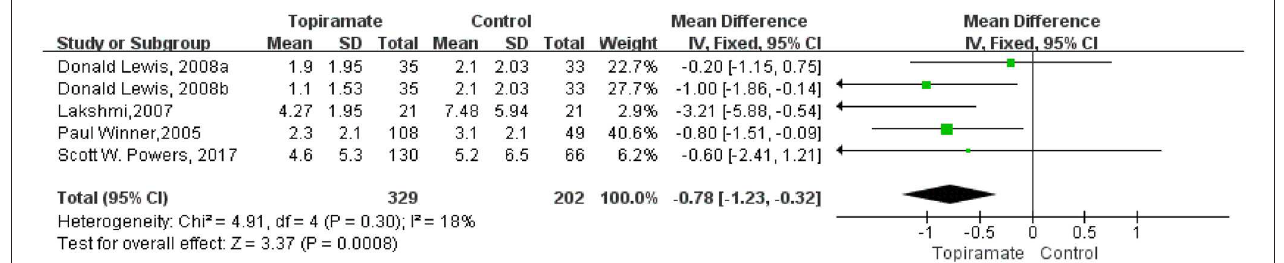
FIGURE 3 | Comparison of the monthly migraine days between topiramate and placebo groups.